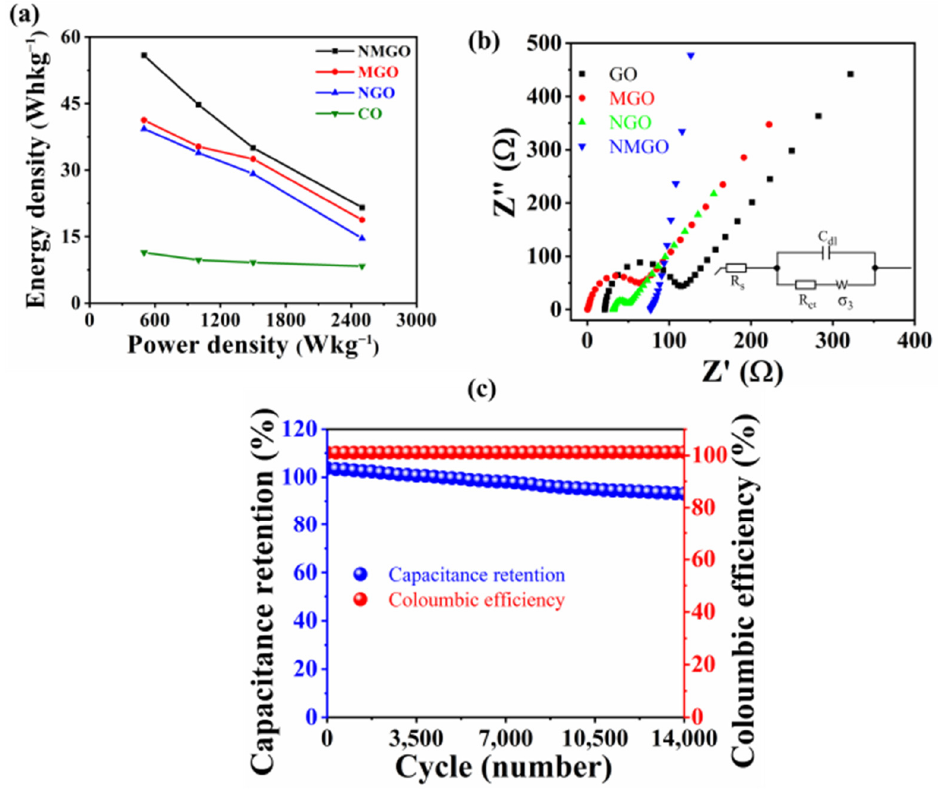
Figure 5. ( a ) Ragone plot for NMGO, MGO, NGO, and GO; ( b ) Nyquist plot for NMGO, MGO, NGO, and GO, and inset is the equivalent circuit used for z-fitting; ( c ) galvanostatic charge and discharge cyclic stability of NMGO .